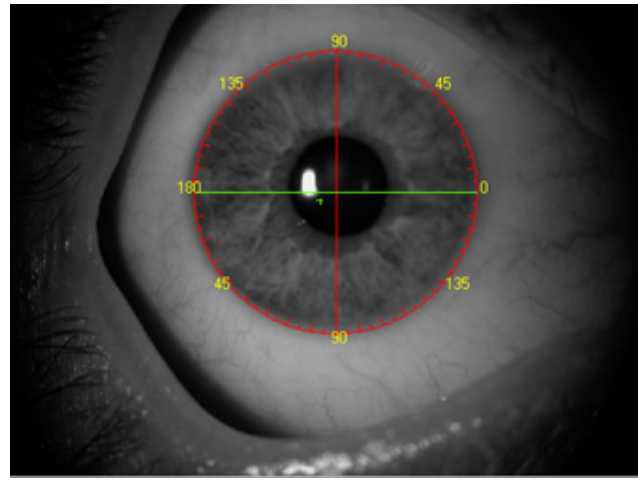
Figure 1. TABO scale.